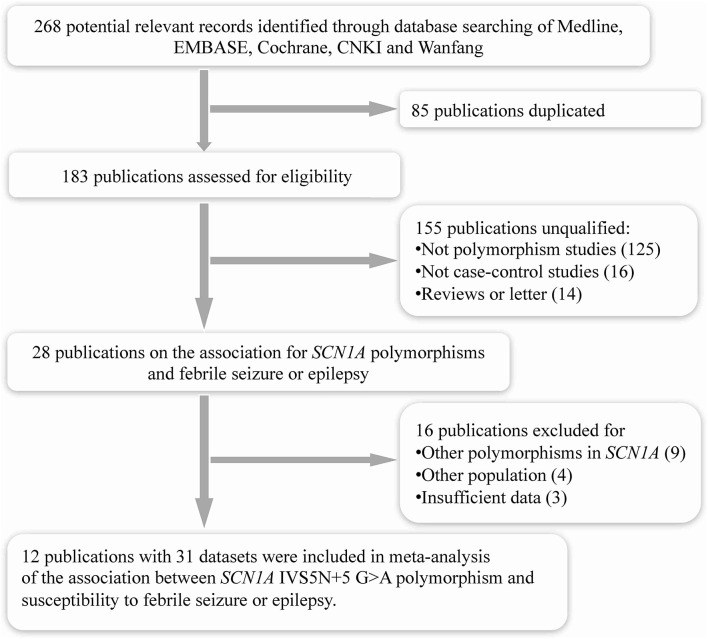
Selection of articles for systematic review.